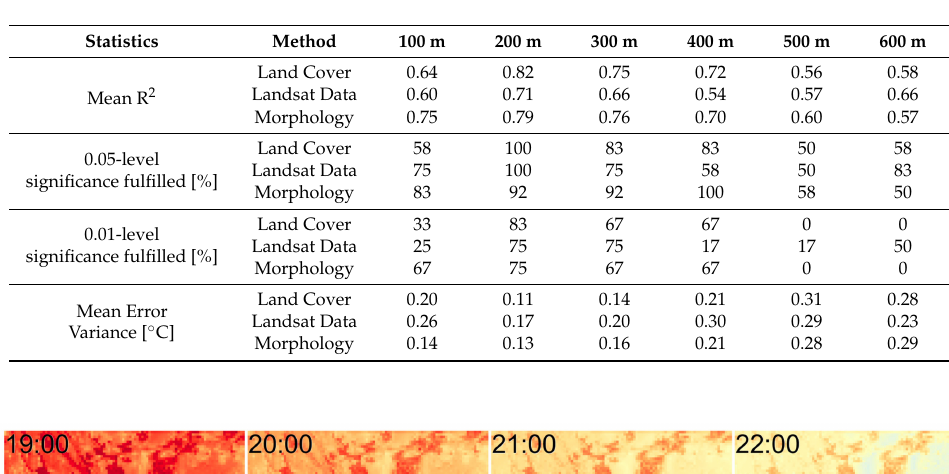
Table 2. Statistics for six different model resolutions derived from hourly model runs between 19:00 and 06:00 CET and three different input datasets. The R 2 statistics and error variances are averaged. The significance-analysis shows the precentral number of runs fulfilling the 0.05/0.01-significance level during the modelling period of 12 h.